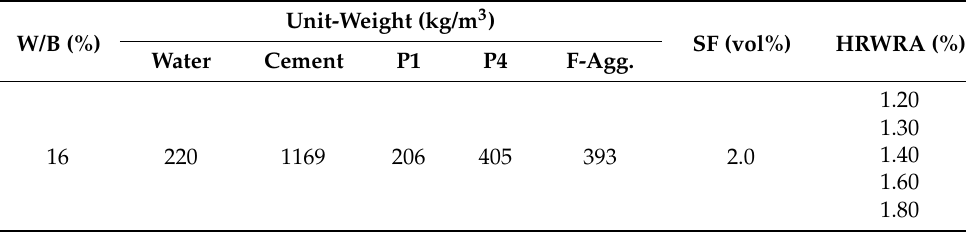
Table 9. Mixture proportions of UHPFRC (a flow test for the effect of HRWRA).